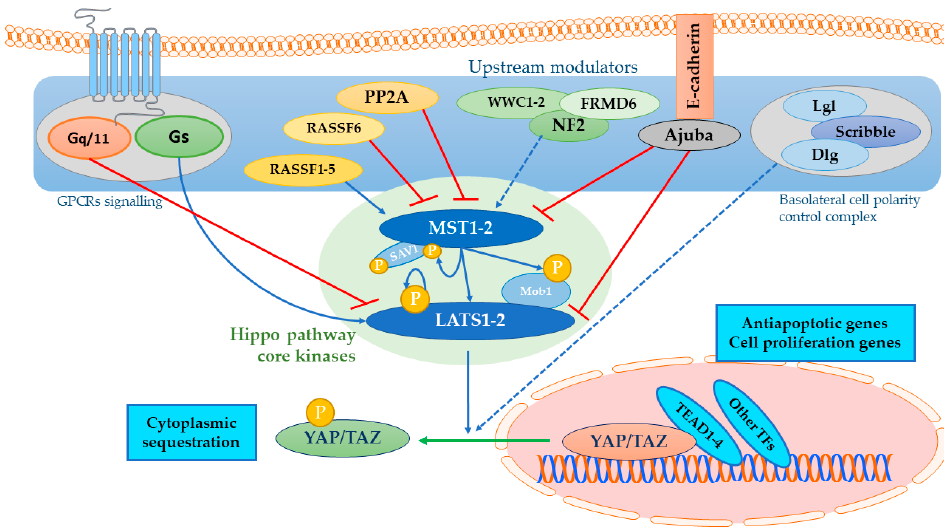
Figure 1. Hippo pathway upstream modulation. Upstream modulators in the blue field regulate Hippo core kinases in the green field, namely MST (mammalian STE20-like protein kinase) 1-2 and LATS (large tumor suppressor) 1-2 [1]. Once phosphorylated, these kinases inhibit YAP (Yes1- associated protein)/TAZ (transcriptional co-activator with PDZ-binding motif) nuclear translocation through serine-phosphorylation, ensuring cytoplasmic compartmentalization and promoting degradation mechanisms. The Hippo pathway induces an onco-protective signal by impairing antiapoptotic and cell proliferation-related genes transcription by the final effectors. G-protein coupled receptors with Gs promote LATS1-2 activation, while other coupling-type mechanisms promote actin cytoskeleton dynamics that impair Hippo kinases activity [12]. The Ras-association